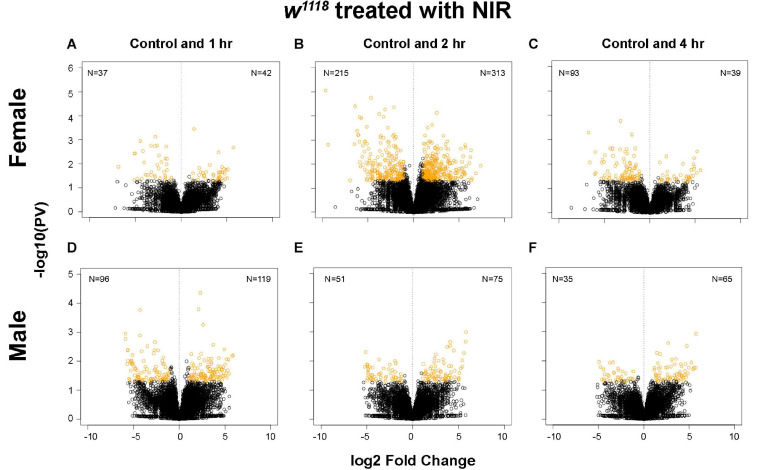
Plot depicting transcriptional changes after NIR exposure in w1118 injured male and female flies. Volcano plots depicting log2 fold change and –log10(PV:p-value) of differentially expressed genes at 1, 2, and 4 hr after injury and subsequent NIR exposure compared to control for females (A–C) and males (D–F). The number of significantly upregulated and downregulated gene changes are indicated in each plot (| log2FC| > 1; p-value < 0.05). Injured w1118 females show more transcriptional changes in response to NIR exposure than males.